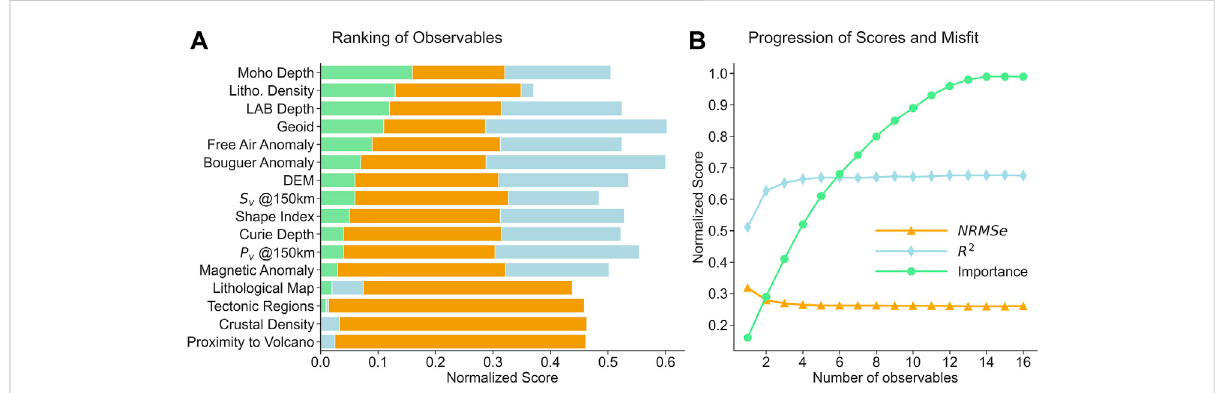
FIGURE 5 (A) Relative importance of the observables, coef fi cient of determination R 2 , and normalized root mean square error NRMSe ranked by their contributiontotheRFprediction, (B) Samescoresasintheleft fi gurebutinacumulativesensefortheentireRFmodelbasedondifferentnumbersof